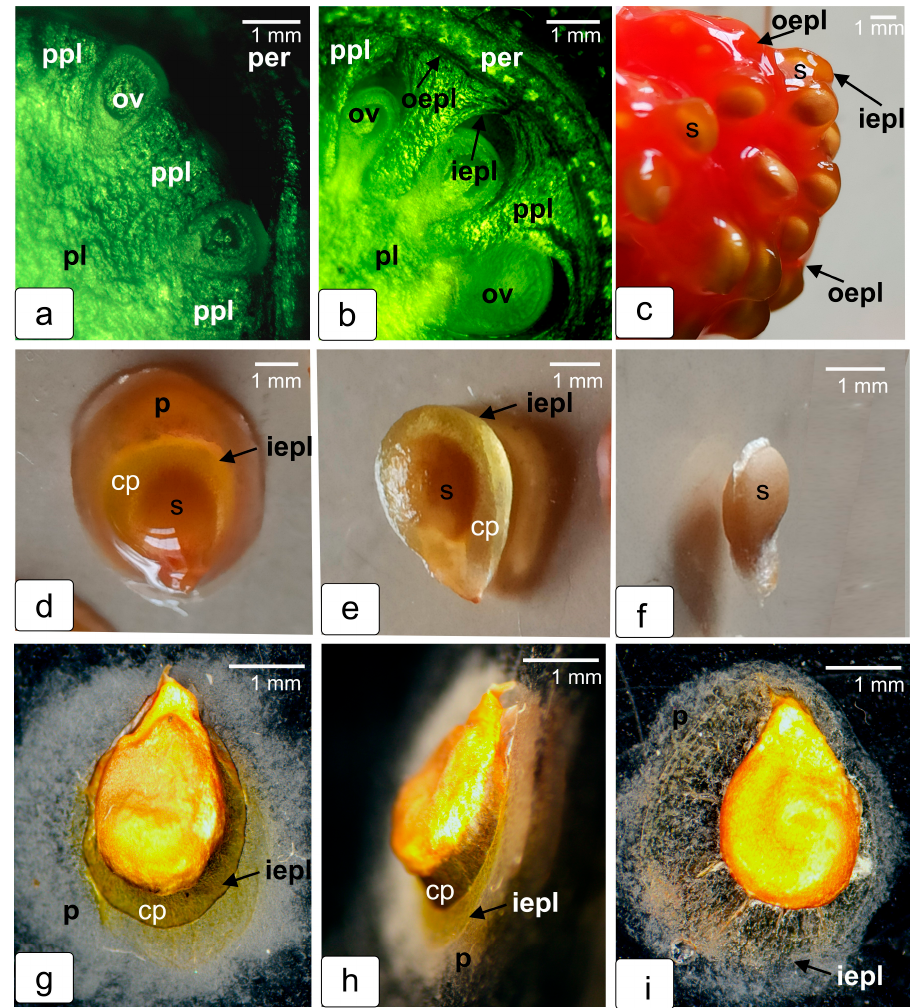
Figure 4. Photographs of freshly extracted internal tissues from tomato fruits. Cuts in the early stages of development: the beginning of parallel growth of ovules and protrusions of placenta tissue ( a ); capsules formed around the ovules ( b ); seeds taken out with gel from a mature tomato fruit ( c ); capsule with a seed and a layer of gel on the surface, extracted from a red fruit ( d ); seed capsule with gel removed ( e ); seed, pulled out of seed capsule ( f ). Seed capsules taken from a ripe fruit and dried on a glass: an intact capsule is stretched over the seed due to the air in it ( g , h ); the previously pierced seed capsule was completely spread on the seed and on the glass ( i ). Designations: cp—seed capsule; oepl—outer epidermis of protrusions of placenta tissue; iepl—inner epidermis of protrusions of placenta tissue; ov—ovule; per—pericarp; pl—placenta; ppl—protrusion of placen-